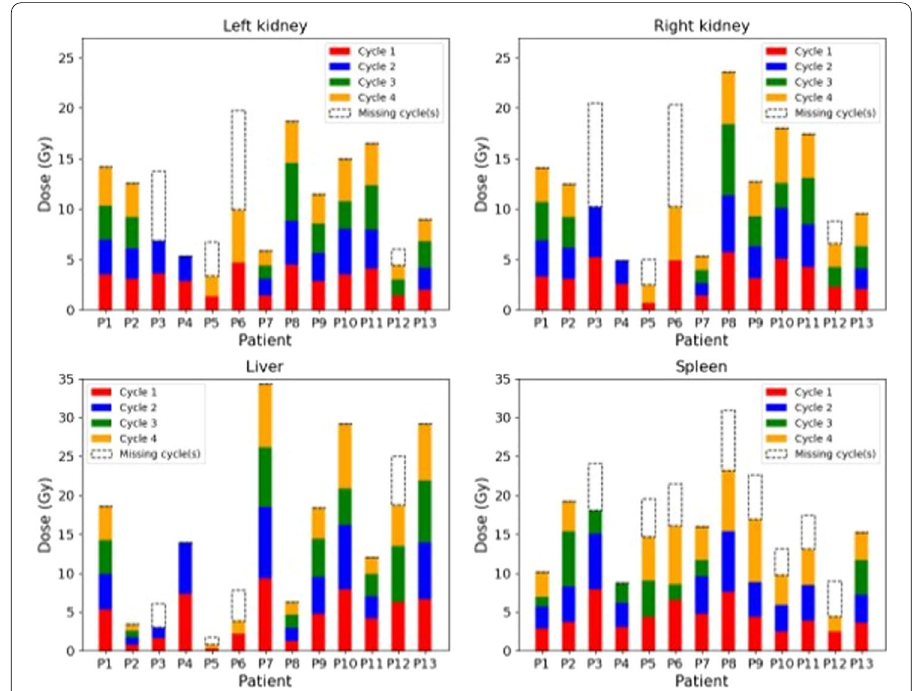
Fig. 2 Absorbed doses (Gy) for 13 patients of the patient cohort and for four volumes (left kidney, right kidney, liver and spleen) for all available cycles. For missing cycles, absorbed dose estimations are in white dotted line